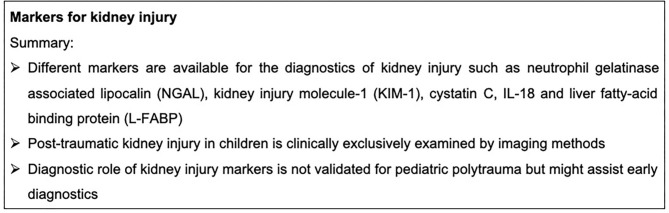
Summary box markers for kidney injury.